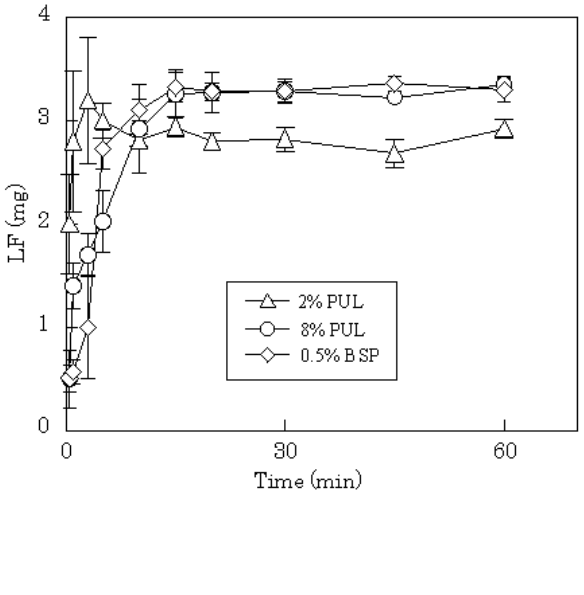
Figure 6. Release profiles of LF from FDFs in physiological